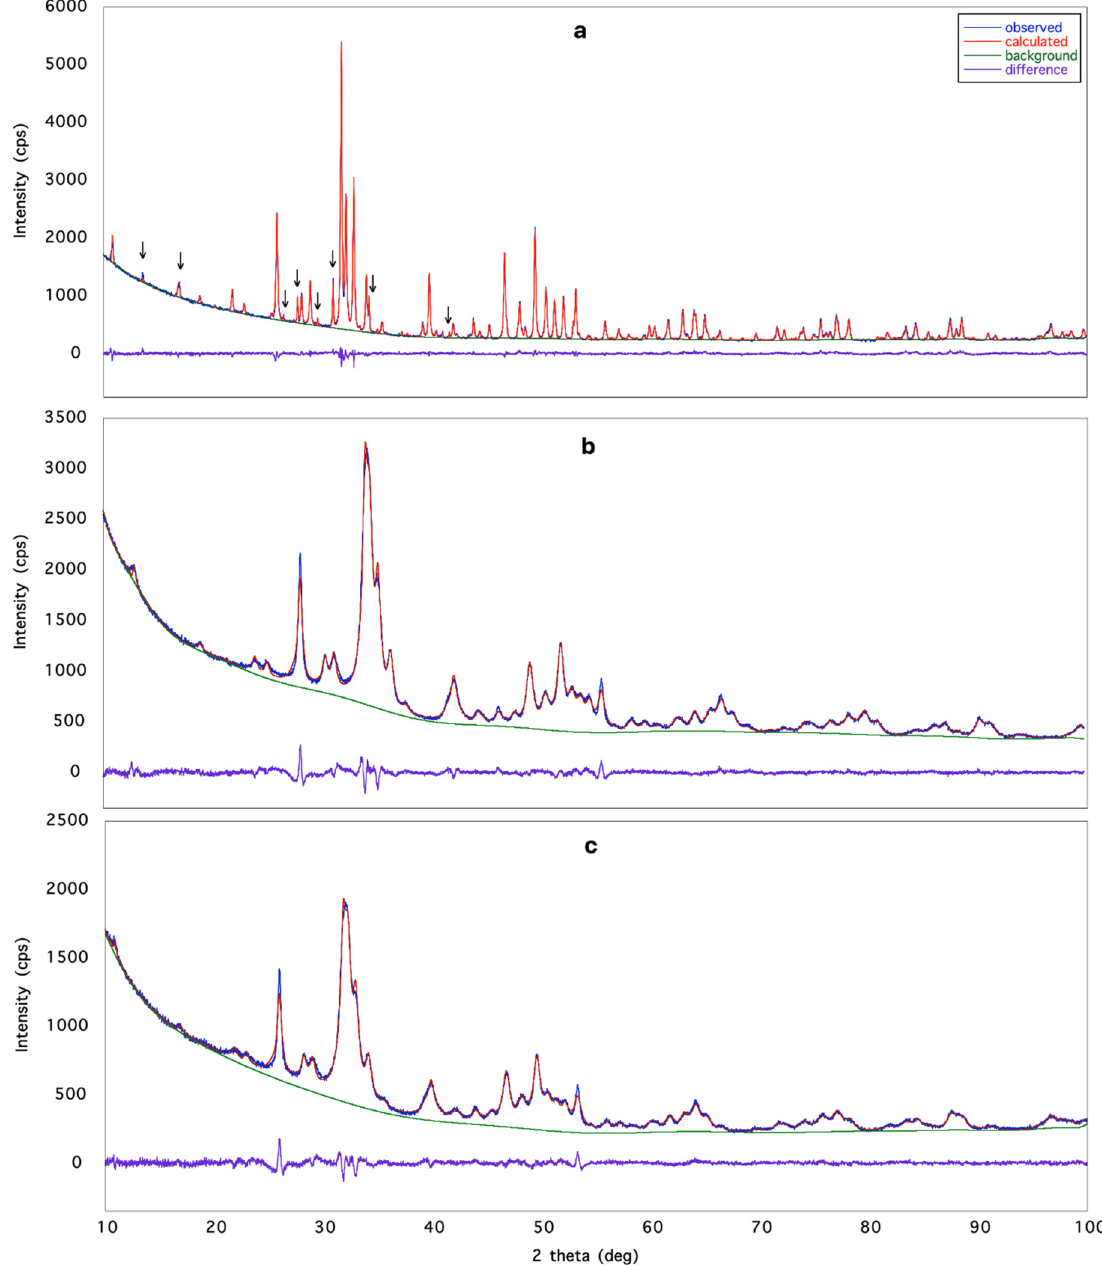
Figure 1. Rietveld plot of: ( a ) Eu-HAp900, ( b ) Eu-HAp450 and ( c ) Eu-HAp120 phases. Observed diffraction profile: blue line; calculated profile: red line; difference profile: violet line; background: green line. Arrowed peaks correspond to the TCP phase [31].